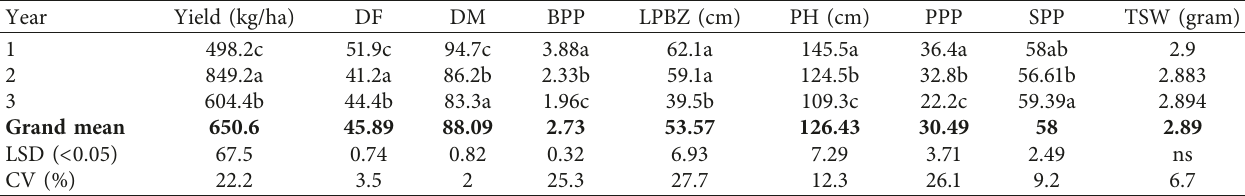
Table 5: Agronomic traits of the sesame genotypes for the three years (growing seasons).